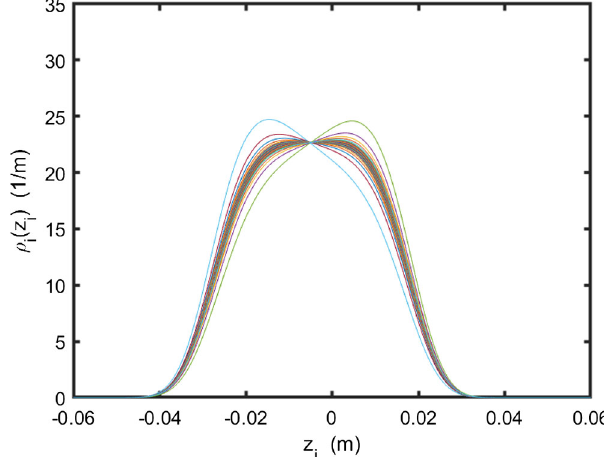
FIG. 10. Case of tapered bunch charges, MC beam loading ¼ 496 omitted, I av